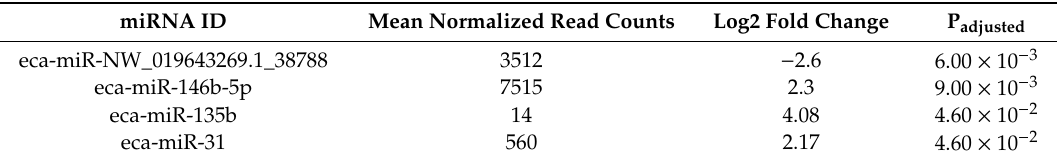
Table 5. Di ff erentially expressed miRNAs comparing asthmatic horses in exacerbation and asthmatic horses in remission. The mean DESeq2 normalized read counts, the log2 fold change, and the adjusted p -values are